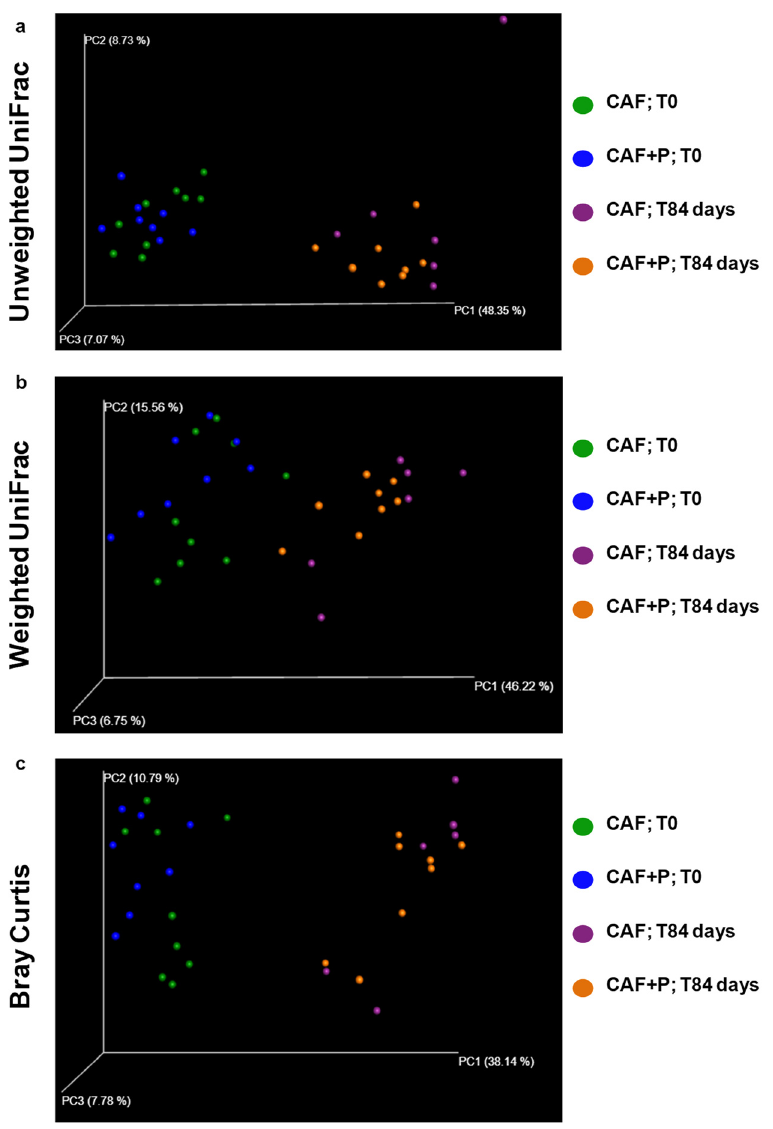
Figure 5. Principal Coordinates Analysis (PCoA) 3D plots. PCoA was performed using Unweighted UniFrac ( a ), Weighted UniFrac ( b ) and Bray-Curtis dissimilarity ( c ) distance matrices. Each sample is represented by a green point for CAF rats at T0, blue point for CAF+P group at T0, violet point for CAF group at T84 days and orange point for CAF+P group at T84 days. CAF: cafeteria; P: probiotic supplementation.